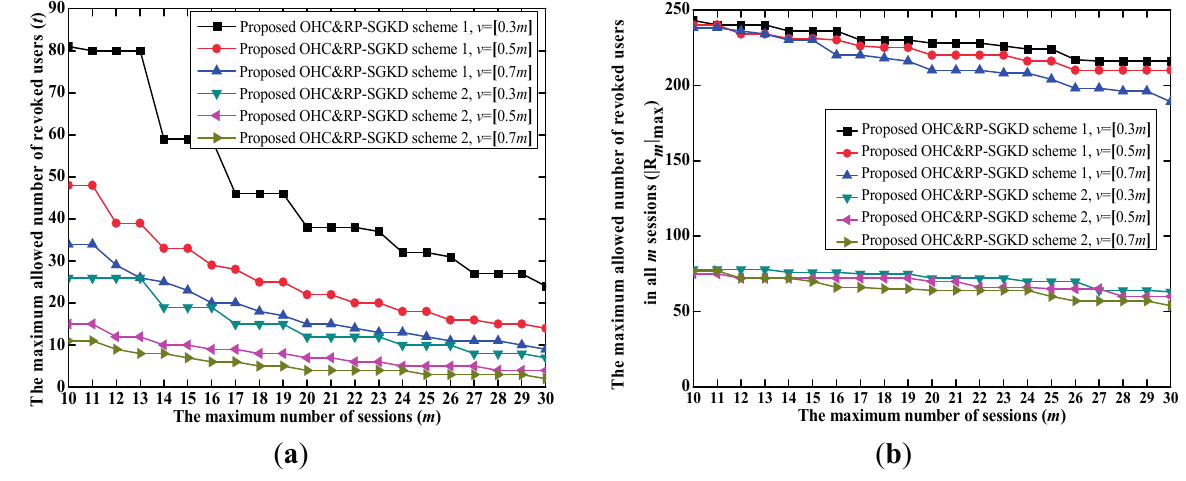
Figure 4. The performance comparison of the proposed one-way hash chain and revocation polynomial-based self-healing group key distribution (OHC&RP-SGKD) schemes 1 and 2. ( a ) The tradeoff between m and t ; ( b ) The tradeoff between m and |R m | max